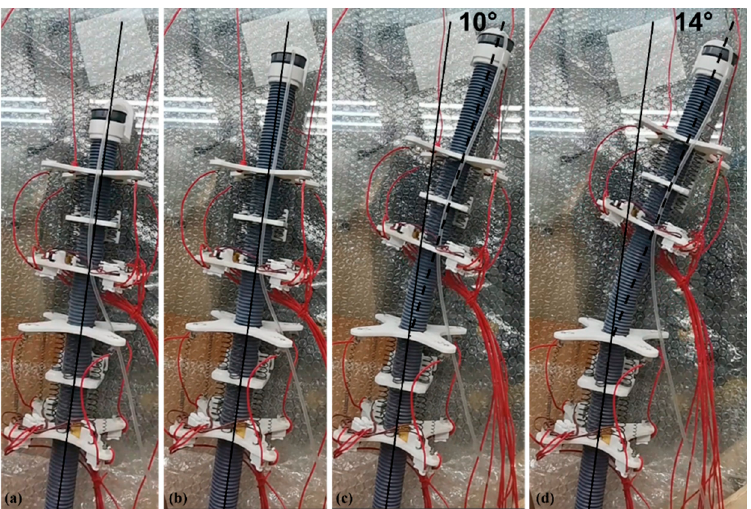
Figure 16. Two-module prototype offset to the right. ( a – d ) represents the motion of the robot.